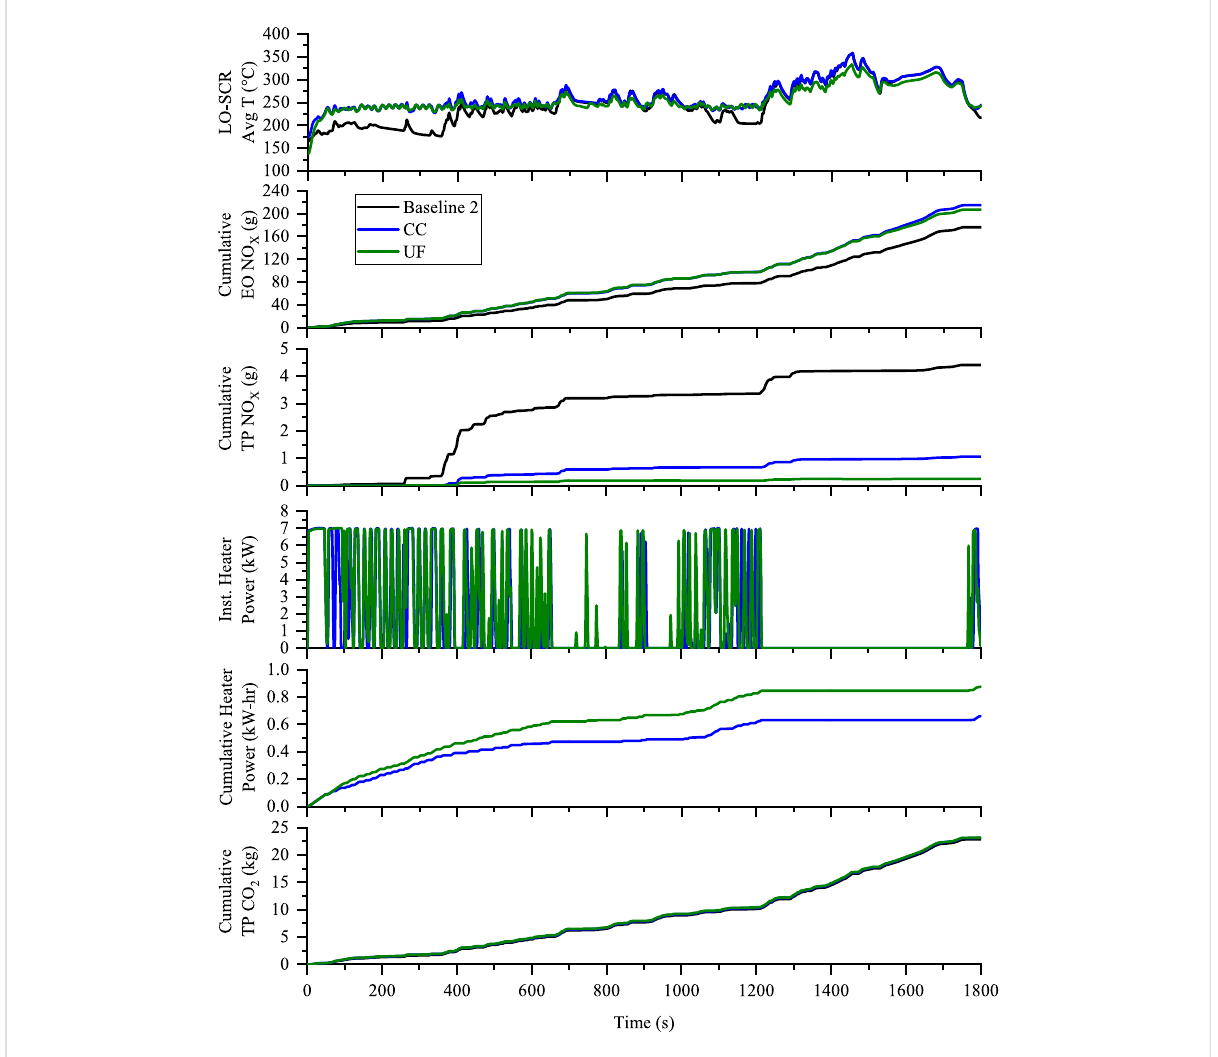
FIGURE 13 Comparison of the CC LO-SCR and UF LO-SCR to Baseline 2 on the hot WHTC for the LO-SCR average temperature, emissions, and heater electrical power